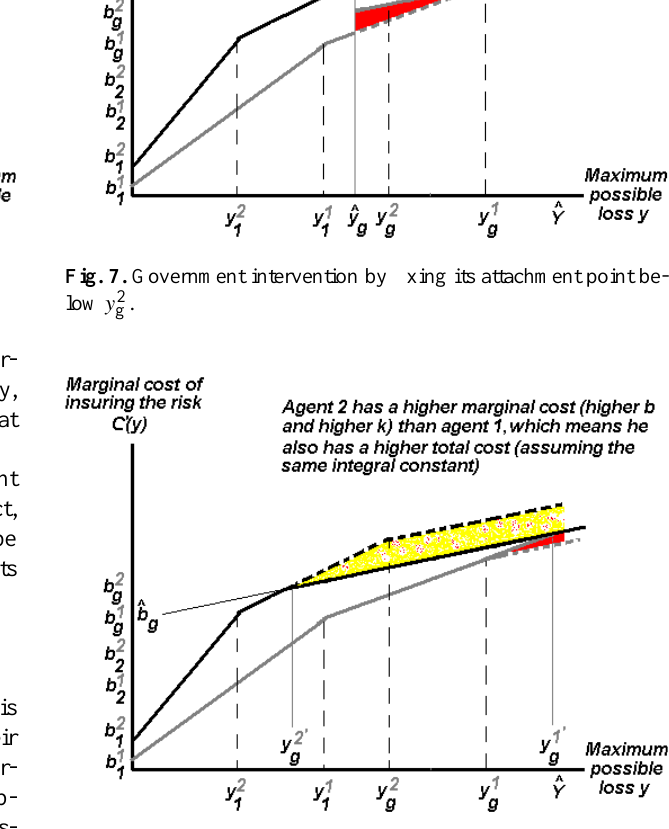
Fig. 8. Government intervention by assigning the same underwrit- ing cost to